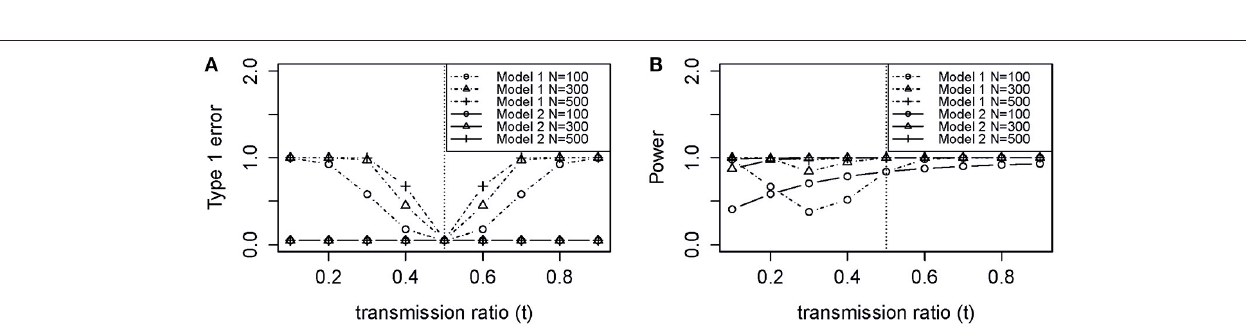
FIGURE 3 | Theoretical (A) type 1 error and (B) power of models 1 (Unadjusted) and 2 (Adjusted) using Equation (A6) and (A7) in Appendix. (A) Type 1 Error (no association between disease and DSL where f 0 = f 1 = f 2 = 0.1). (B) Power (true association between disease and DSL where f 0 = 0.1, f 1 = 0.2, f 2 = 0.3). N , sample size (100, 300, and 500); f 0 , penetrance for genotype 0 individuals; f 1 , penetrance for genotype 1 individuals; f 2 , penetrance for genotype 2